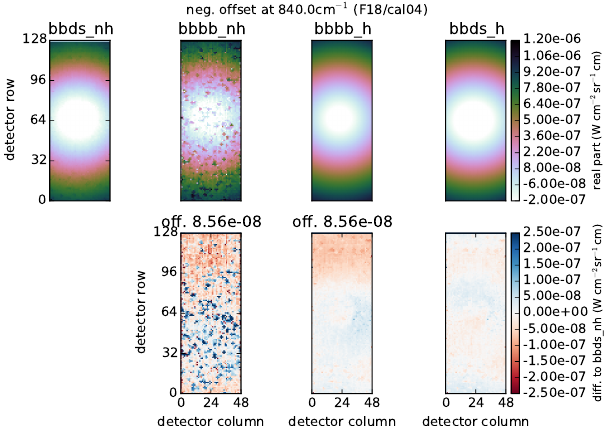
Figure 5. Averaged real part of the NCO over the detector rows for the different calibration methods. Both the unmodified data (suffix nh) and the pseudo-hyperbolas (suffix h) are shown. A discrepancy remains between the BB-DS and BB-BB methods which has to be compensated for in the trace gas